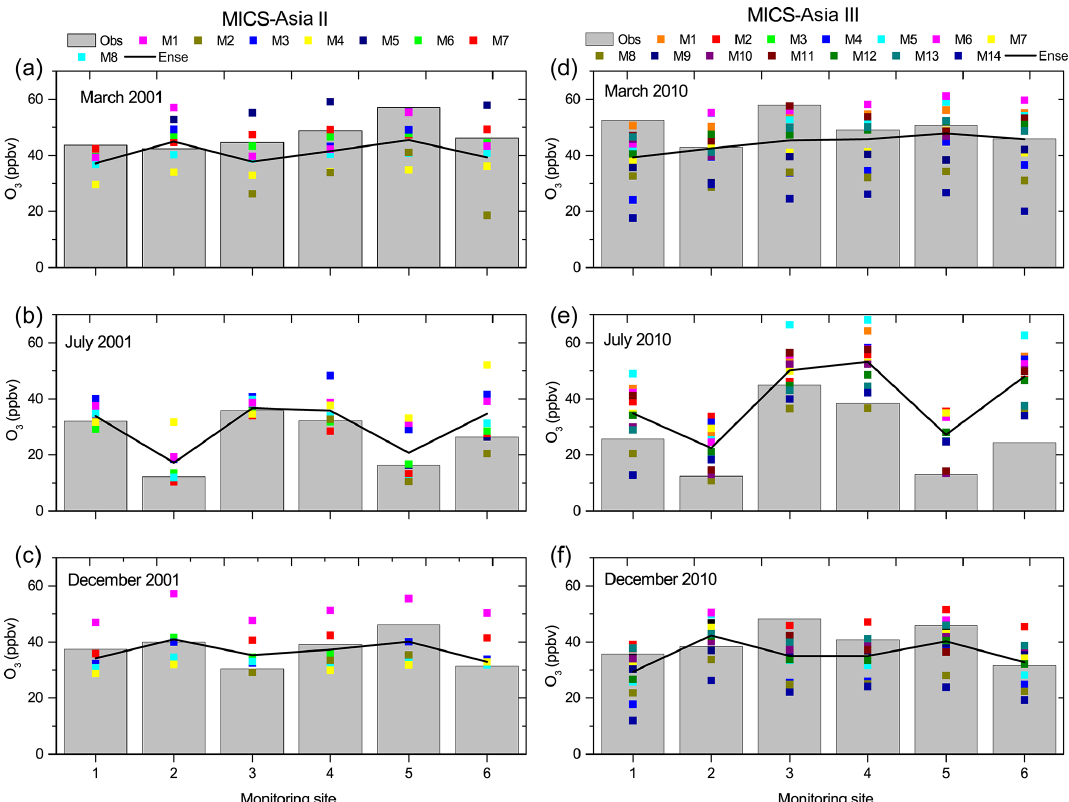
Figure 8. Modeled and observed monthly mean concentrations of O 3 for EANET sites in phases II (a–c) and III (d–f) of the MICS-Asia project. The solid line represents the ensemble mean. Note that MICS-Asia II and III data refer to March, July and December of 2001 and 2010, respectively. IDs of the monitoring sites denote the following: 1 – Rishiri (45.12 ◦ N, 141.23 ◦ E), 2 – Ogasawara (27.83 ◦ N, 142.22 ◦